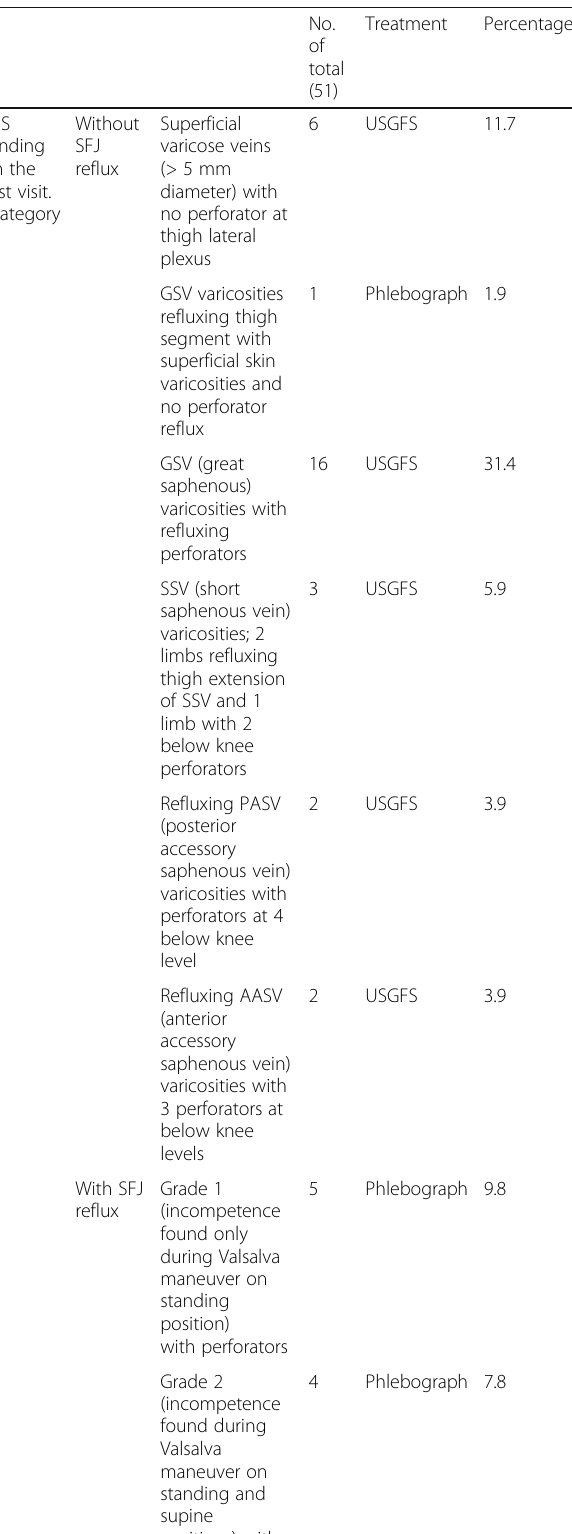
Table 5 The 1st visit US findings and the distribution of the